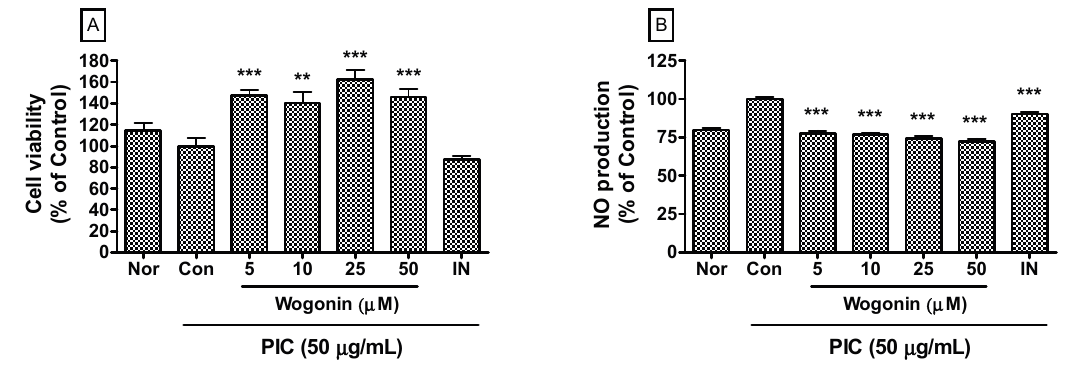
Figure 2. Effects of wogonin on cell viability and NO production in dsRNA-induced RAW 264.7 mouse macrophages. After 24 h treatment, cell viability ( A ) was evaluated by a modified MTT assay and NO production ( B ) was measured by the Griess reaction. Normal group (Nor) was treated with media only. Control group (Con) was treated with the synthetic analog of dsRNA (PIC, 50 µg/mL of polyinosinic-polycytidylic acid) alone. IN denotes indomethacin (0.5 µM). Values are the mean ± SD of three independent experiments. ** P < 0.01 vs. Con; *** P <